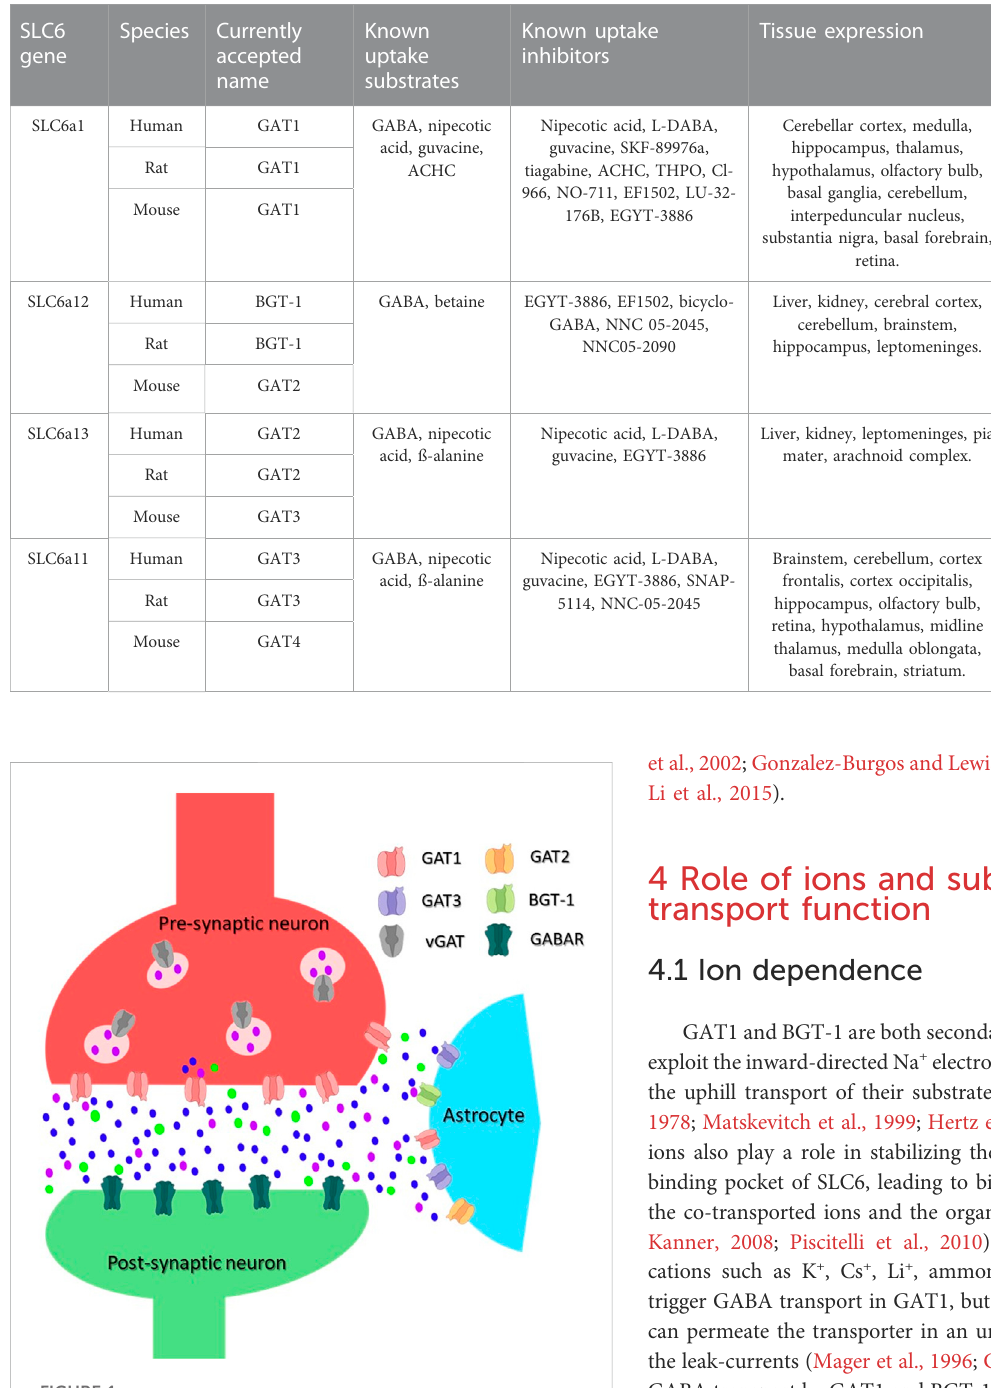
FIGURE 1 Scheme of an inhibitory synapse showing the distribution of GATs. In the pre-synaptic terminal of GABAergic neurons, GABA is synthesized from glutamate and packaged into vesicles by vesicular GAT (vGAT). GABA is released into the synaptic cleft upon depolarization of the plasma membrane. An inhibitory signal can be generatedinthepost-synapticneuronbyitsbindingtoandopeningof the ionotropic GABA receptors (GABAR). Released GABA is removed from the synaptic cleft by GATs, the transport is energized by co- transport of Na + /Cl − . The main GABA transporter in neurons is GAT1, whereas in astrocytes, mainly GAT3 but also GAT2 and BGT-1 are responsible for the GABA transport. GABA molecules are shown as purple dot, Na + ions as blue dot, and Cl − as green